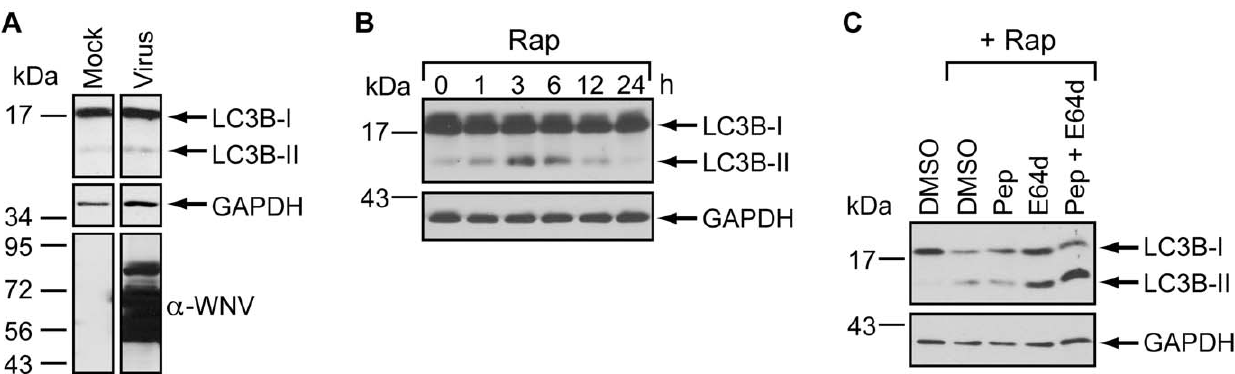
Figure 2. LC3B-II accumulation in 293T cells. (A) Effect of WNV infection on LC3-II levels. Whole cell lysates were prepared from mock-infected or WNV-infected (MOI=3) 293T cells at 24 hours post-infection. Immunoblot anyalysis was used to determine steady-state levels of LC3B (top), GAPDH (middle), and WNV (bottom). (B) Effect of rapamycin on LC3B. Whole cell lysates prepared at the indicated times (h) from 293T cells treated with 100 nM rapamycin (rap) were subjected to immunoblot analysis to determine the steady-state levels of LC3B (top) and GAPDH (bottom). (C) Effect of protease inhibitors on LC3B-II levels. Whole cell lysates were prepared from 293T monolayers treated with rapamycin (Rap) in the presence or absence of pepstatin A (Pep) and/or E64d at 24 hours post-treatment. Lysates were subjected to immunoblot analysis as described in Panel